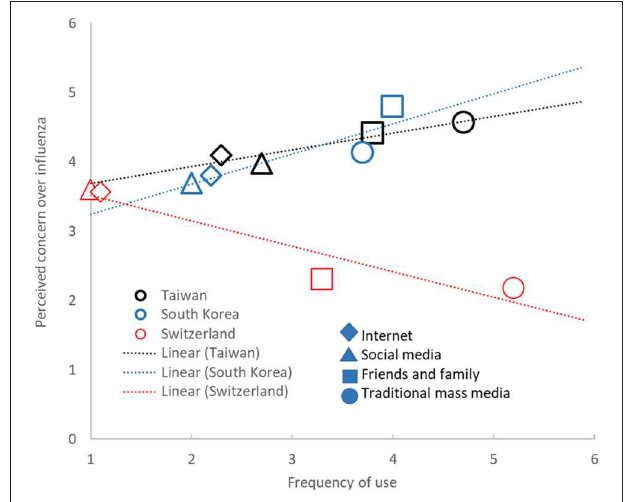
FIGURE 1 | Means of concern and use measures by country and type of channel.